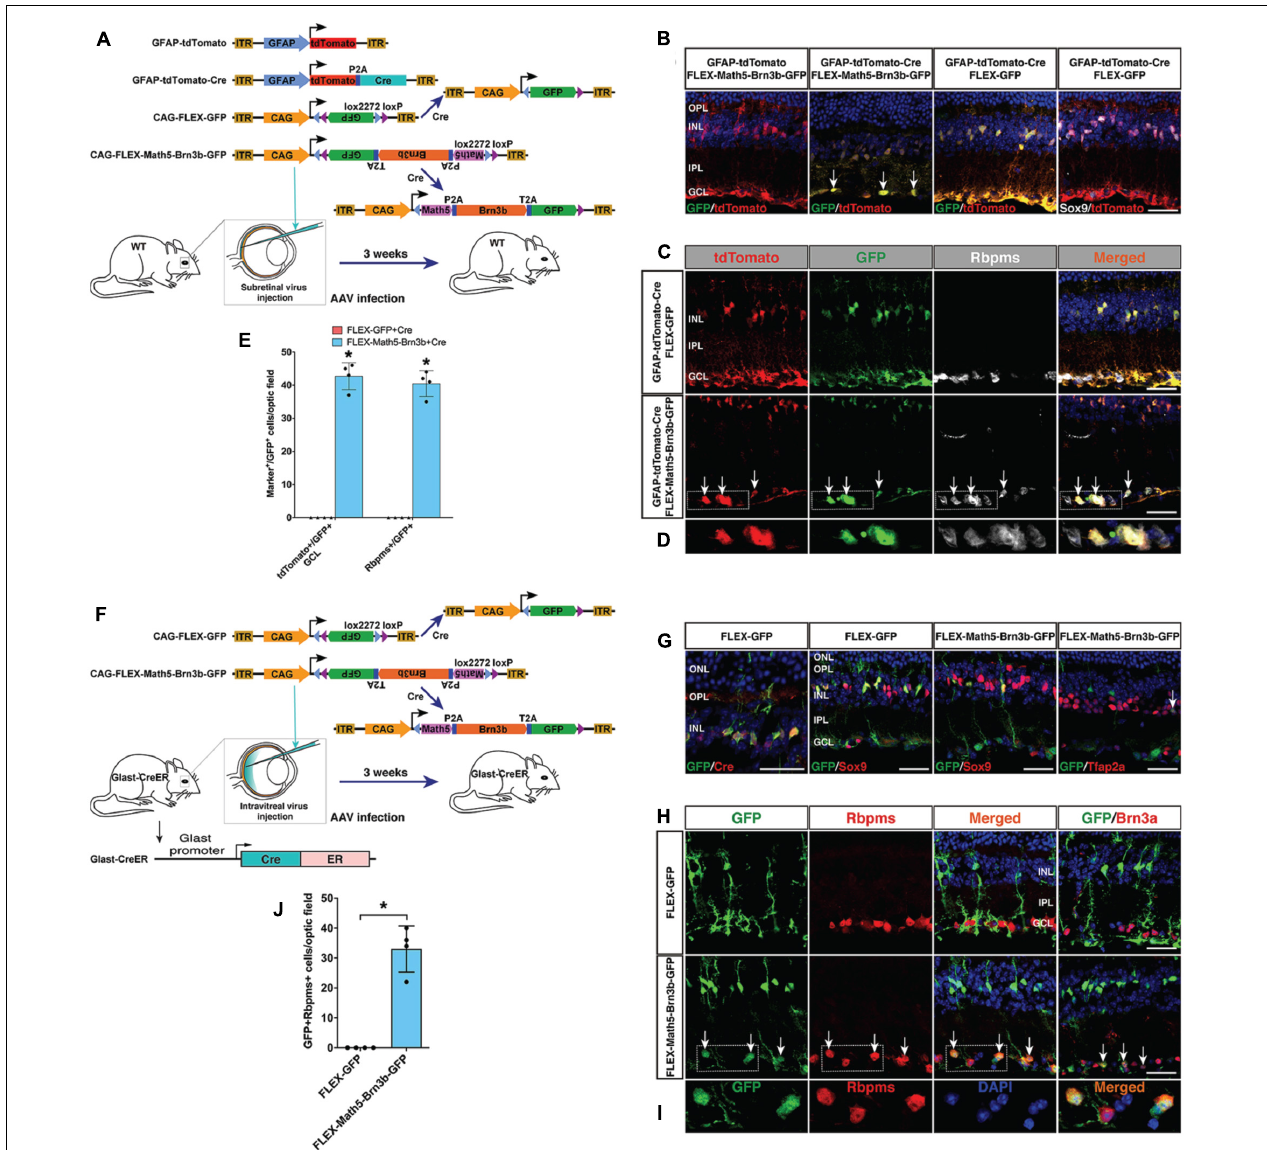
FIGURE 3 | Lineage tracing analysis of MG-derived RGCs. (A) Schematic of the AAV constructs and infection procedure as well as the resulting FLEX AAV constructs in the presence of Cre. (B) Three weeks after injection of the indicated AAVs, sections from infected retinas were double-immunolabeled with the indicated antibodies and counterstained with DAPI. Arrows point to representative double-positive cells located within the GCL. (C,D) Three weeks after injection of the indicated AAVs, sections from infected retinas were triple-immunolabeled with the indicated antibodies and counterstained with DAPI. Arrows point to representative triple-positive cells located within the GCL. Shown in (D) are higher magnification single-plane confocal images of the outlined region in (C) . (E) Quantitation of tdTomato+/GFP+ cells in the GCL as well as Rbpms+/GFP+ cells. Data are presented as mean ± SD ( n = 4). Asterisks indicate significance in unpaired two-tailed Student’s t -test: * p < 0.0001. (F) Schematic of the FLEX AAV constructs, resulting FLEX AAV constructs in the presence of Cre, infection procedure, and the Glast-CreER mice. (G) Three weeks after injection of the indicated AAVs, sections from infected retinas were double-immunolabeled with the indicated antibodies and counterstained with DAPI. The arrow points to a double-positive cell located within the INL. (H,I) Three weeks after injection of the indicated AAVs, sections from infected retinas were double-immunolabeled with the indicated antibodies and counterstained with DAPI. Arrows point to representative double-positive cells located within the GCL. Shown in (I) are higher magnification single-plane confocal images of the outlined region in (H) . (J) Quantitation of GFP+/Rbpms+ double-positive RGCs. Data are presented as mean ± SD ( n = 4). Asterisks indicate significance in unpaired two-tailed Student’s t -test: * p < 0.0005. GCL, ganglion cell layer; INL, inner nuclear layer; IPL, inner plexiform layer; OPL, outer plexiform layer. Scale bars = 30 µ m (B,C,G,H)